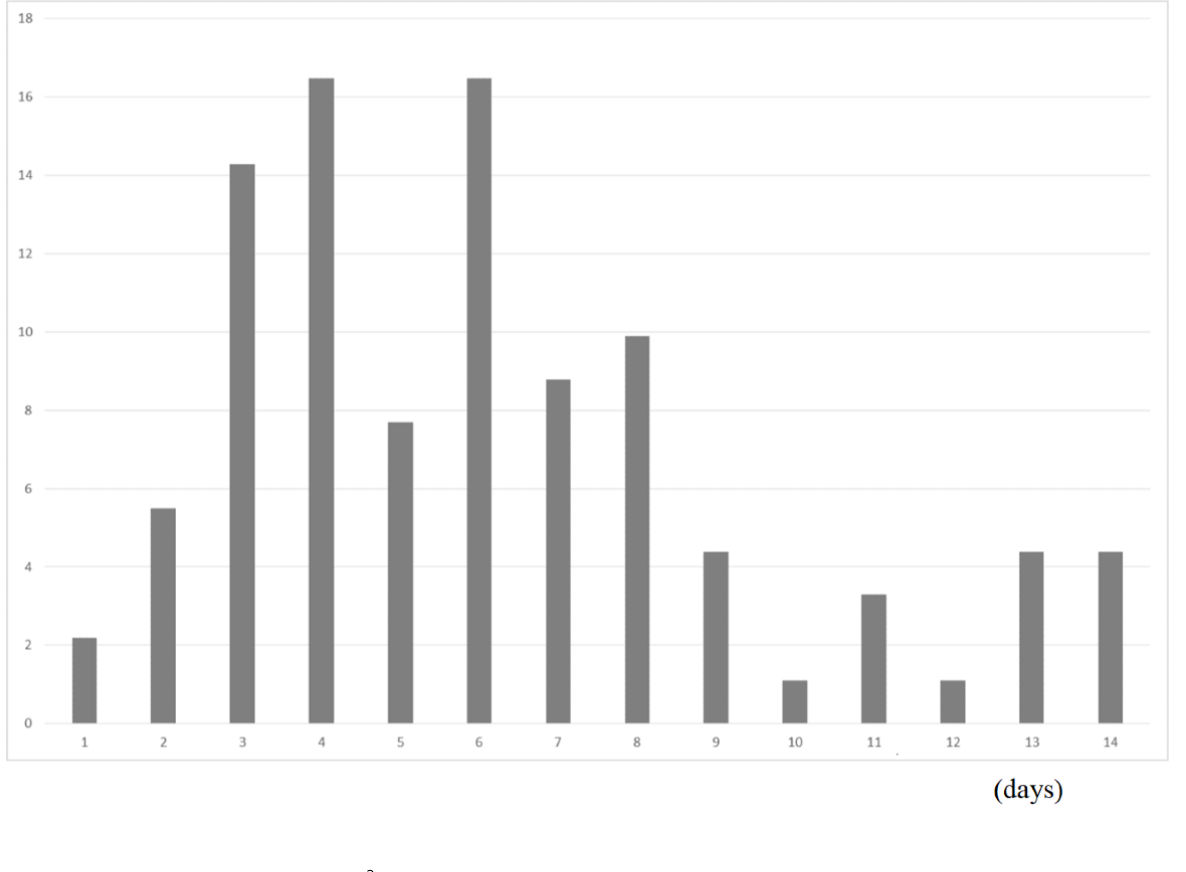
Table 1. Results of estimate R( t ) for Apple data. a